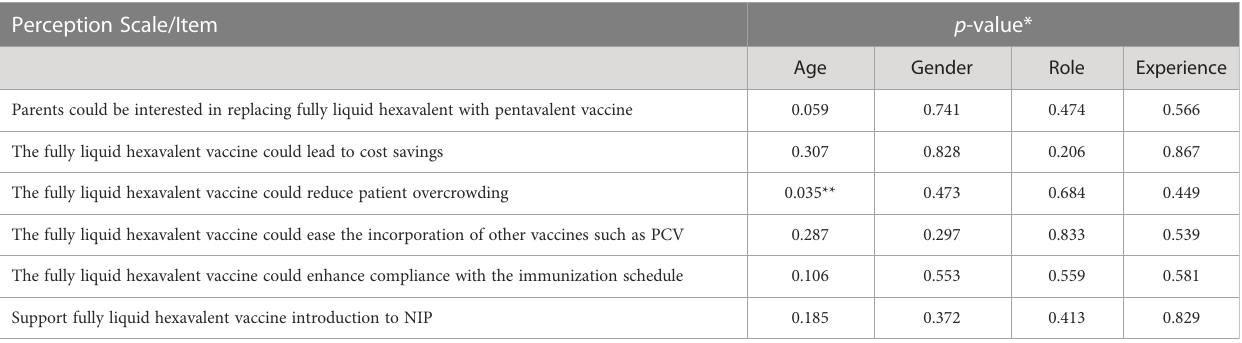
TABLE 4 Factors associated with physicians ’ fully liquid hexavalent vaccine perception ( n = 50). Perception